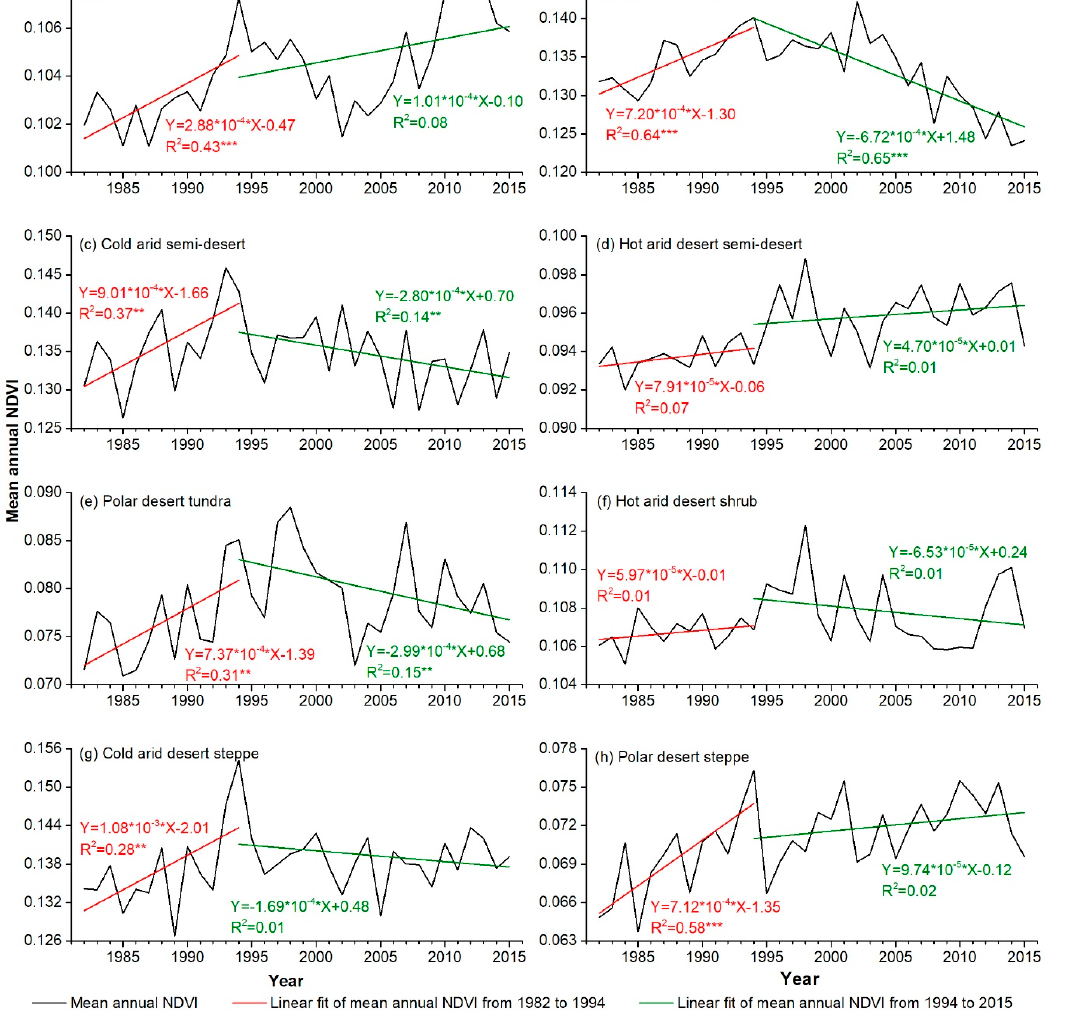
Figure 3. Interannual change of mean annual NDVI in different desert areas over the Silk Road Economic Belt from 1982 to 2015. ** and *** indicate statistical significance at p < 0.05 and p < 0.01, respectively.